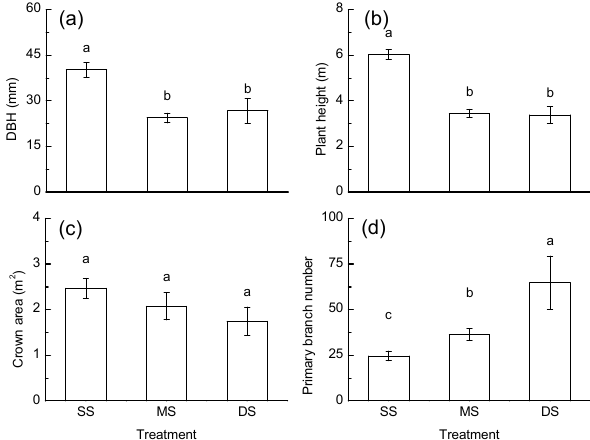
Figure 4. Diameter at breast height (DBH) ( a ), tree height ( b ), crown area ( c ) and primary branch number ( d ) of S. matsudana under shallow submergence (SS), moderate submergence (MS) and deep submergence (DS) treatment in the hydro-fluctuation zone of the TGDR. Different letters on each bar represent significant difference among treatments at the 0.05 level. Values are means ± standard error ( n = 9).